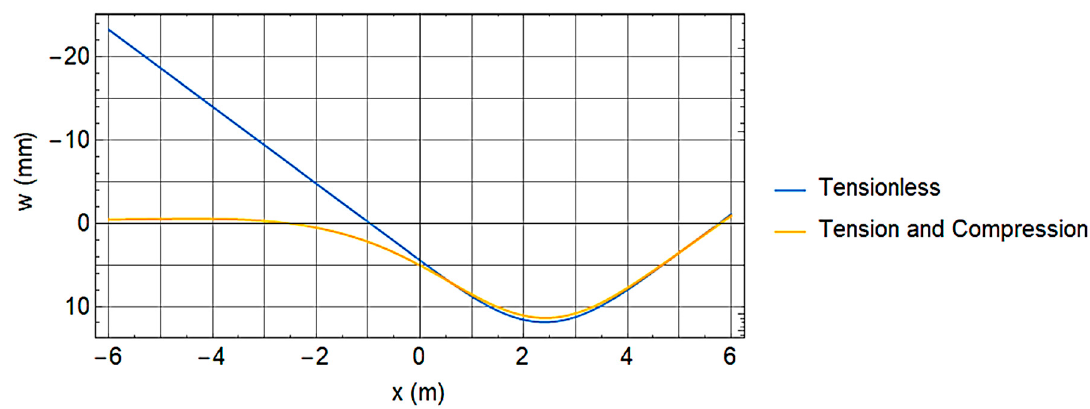
Figure 10. The deflection results for the asymmetric case (X = L/5 )